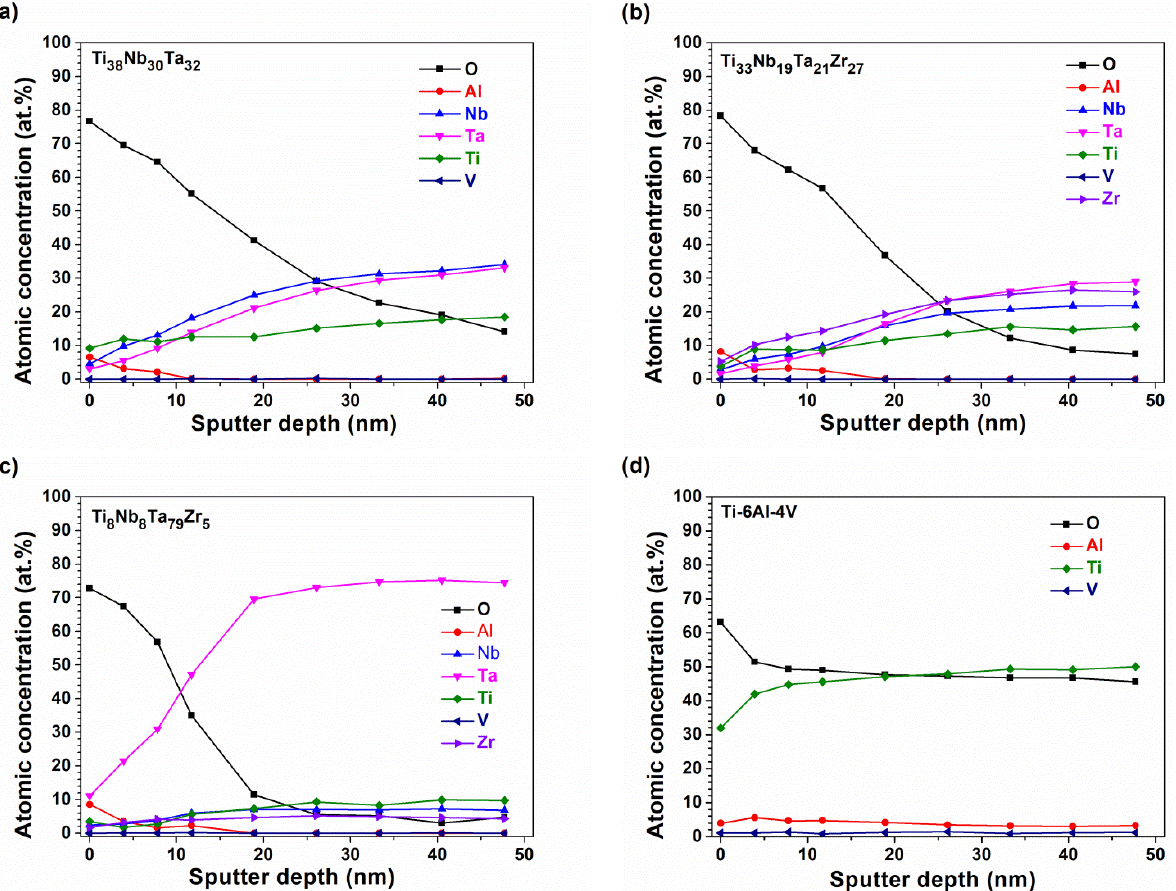
Figure 7. Compositional profiles of ( a ) Ti 38 Nb 30 Ta 32 , ( b ) Ti 33 Nb 19 Ta 21 Zr 27 , and ( c ) Ti 8 Nb 8 Ta 79 Zr 5